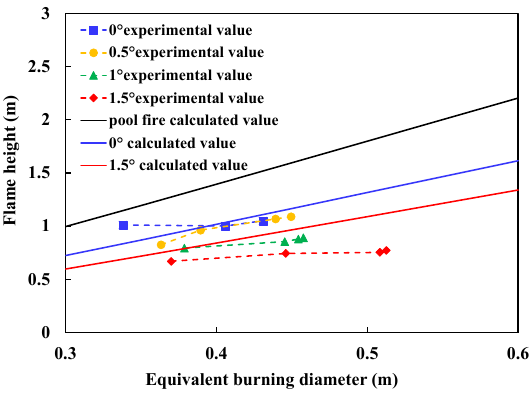
Figure 9. Comparison of Flame Height and Calculated Value.